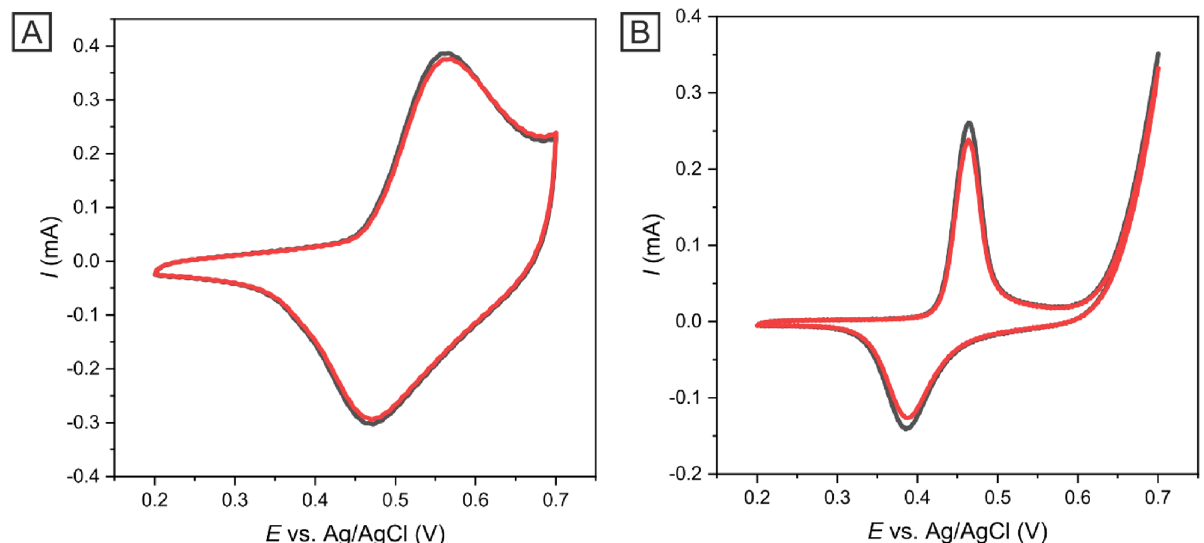
Figure 8. CV measurements used for the evaluation of the stability of Ni-c-ITO using 1 × 10 –3 mol dm −3 K 3 [Fe(CN) 6 ]/K 4 [Fe(CN) 6 ] in 1 mol dm −3 KCl at 50 mV s −1 ( A ) and 2 × 10 –6 mol dm −3 insulin in 0.1 mol dm −3 NaOH and PBS ( B ). Black line (1st measurement) and red line (50th